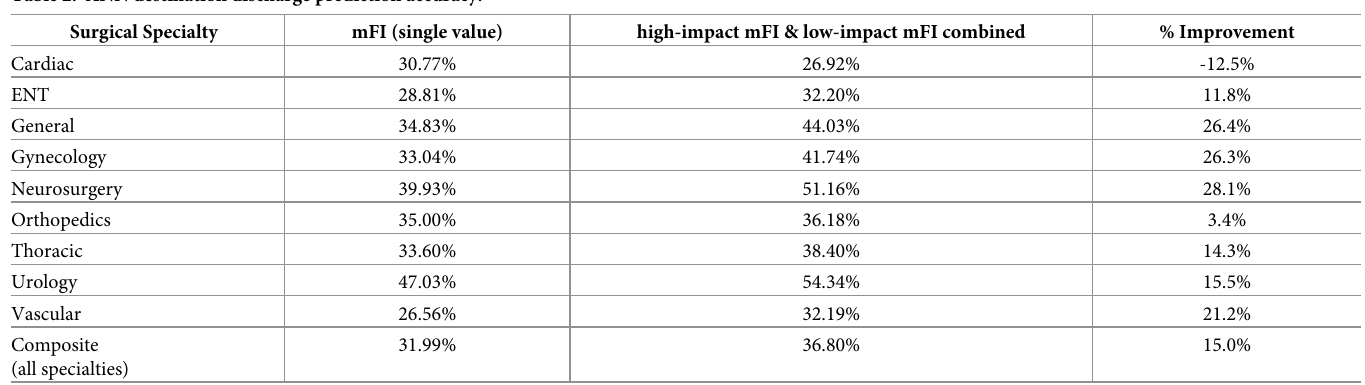
Table 2. ANN destination discharge prediction